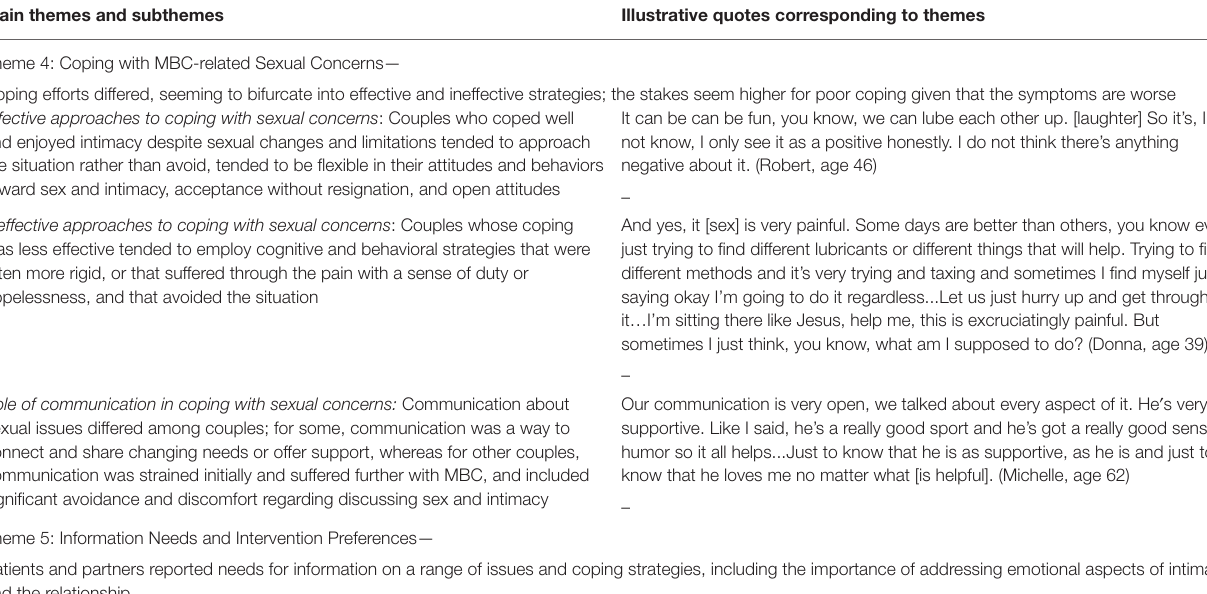
TABLE 4 | Part 2: Qualitative themes 4–5 and illustrative quotes: coping with MBC-related sexual changes, information needs, and intervention